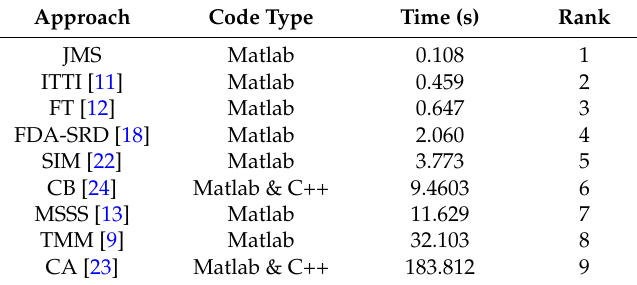
Table 2. Comparison of the average time (size per image of 1024 × 1024) taken for different saliency approaches.